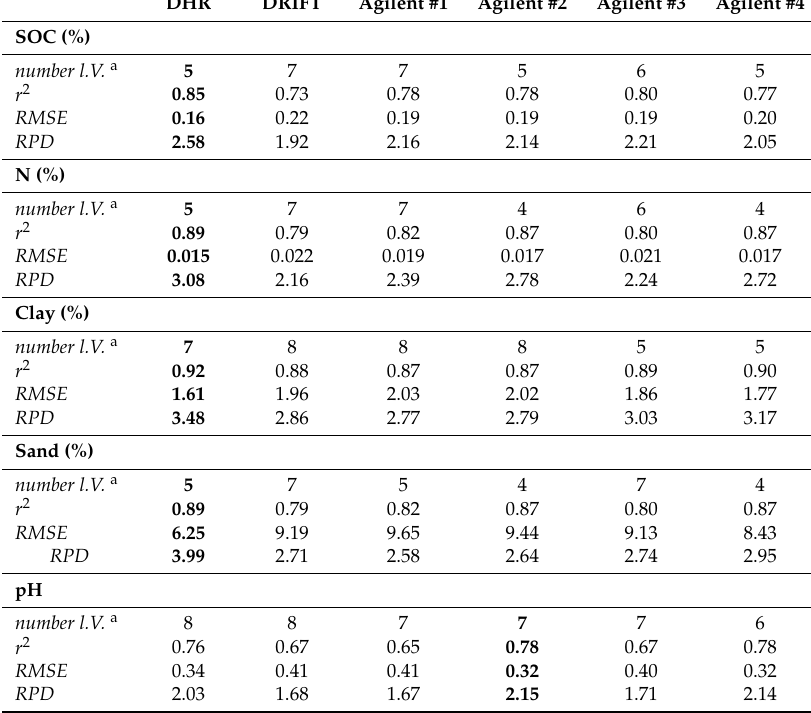
Table 3. PLS regression results (averaged from 1000 runs of 10-fold CV with best results for each soil property in